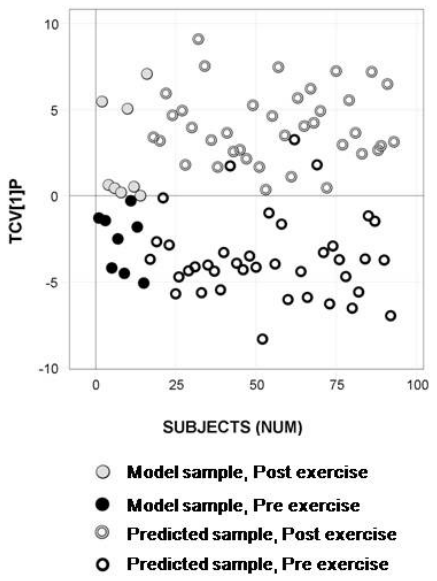
Figure 2. Classification model of the subset selected based on analytical data, including sample predictions. OPLS-DA predictive score plot showing separation between pre- exercise (black circles) and post- exercise (gray circles) serum samples with a cross-validated classification accuracy of 93.8% (Class prediction (CV)). Predictively classified test samples (remaining samples from test occasion one and two), marked as open circles, display high predictive classification accuracy (Class Prediction (Test set): 96.1%) for pre- exercise samples (black open circles) and post- exercise samples (gray open circles).